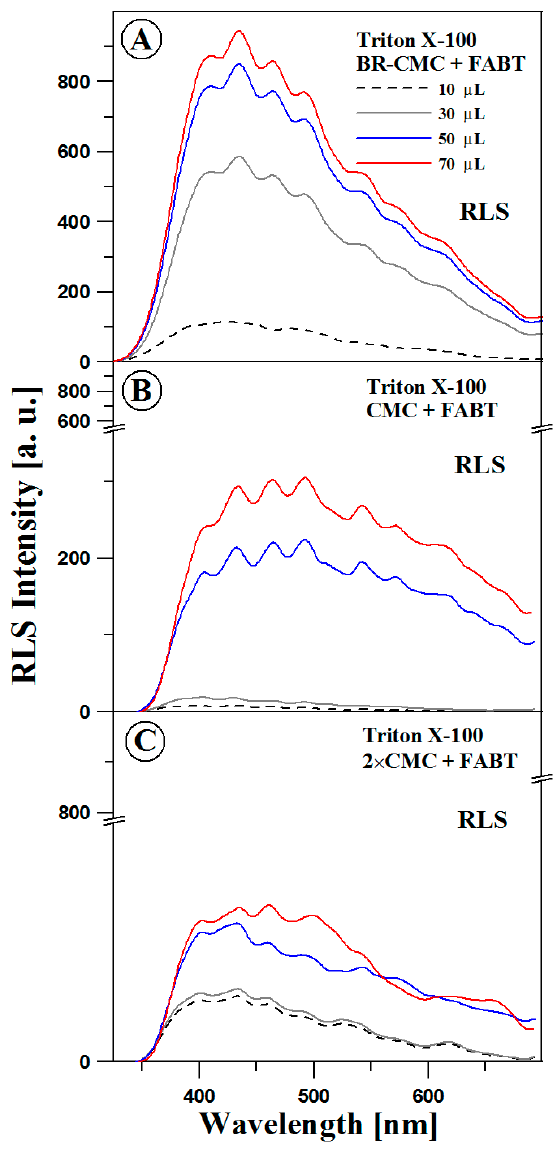
Figure 6. Spectra of resonance light scattering (RLS) in an experiment analogical to that in Figures 2–5 and 7, 9 and 10. The measurements were performed at the temperature of 22 ◦